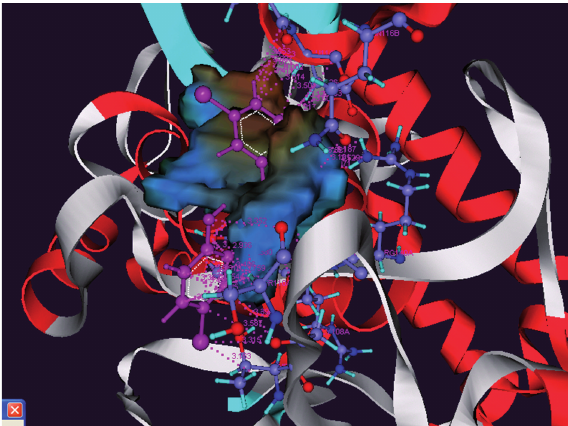
F 6: Interaction of compound 4r with mushroom